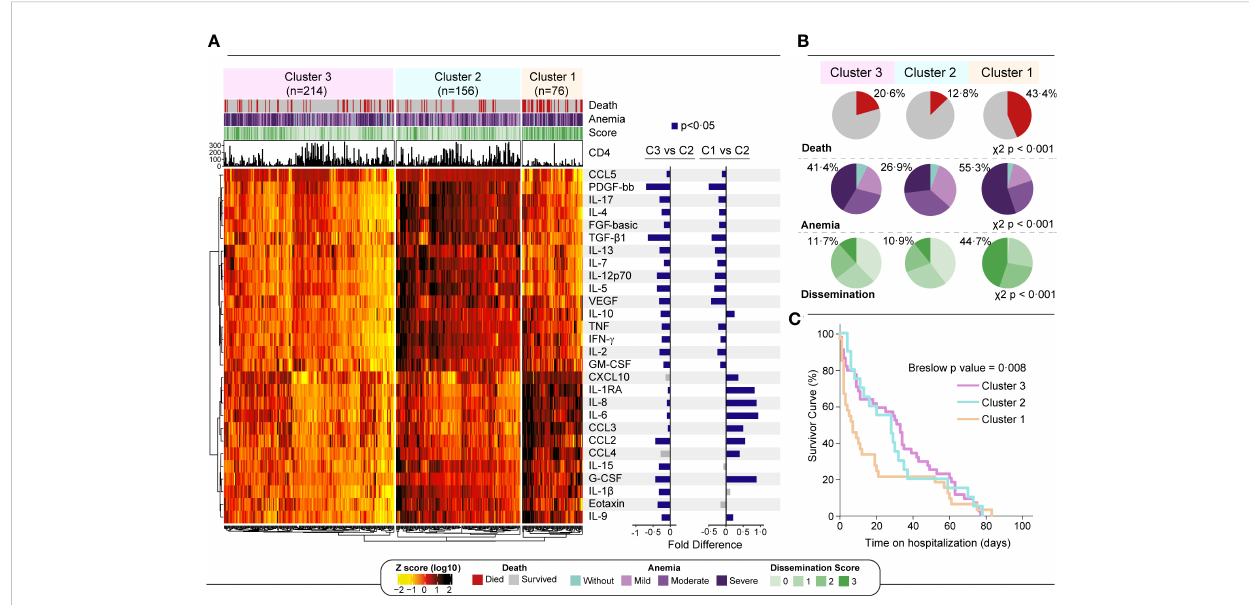
FIGURE 4 A more pronounced in fl ammatory pro fi le is associated with severe anemia and death. (A) Left panel: An unsupervised two-way hierarchical cluster (Ward ’ s method) was performed with all 496 participants. Data were log10 transformed and ranked and colored in a heatmap from values detected for each in fl ammatory biomarker. Dendrograms represent Euclidean distance. Three main clusters were de fi ned. Right panel: A log10 fold change was performed comparing each cluster with reference cluster (C2, due to lowest frequency of dissemination and death). Signi fi cant differences (p < 0.05) are highlighted in blue bars. (B) For each cluster, shaded areas represent frequency of death (red), anemia severity grade (light blue to dark purple) and Mtb dissemination score (light green to dark green) and. Chi squared test was performed to each variable comparing clusters. (C) Survivor curves show the probability of survival over 12 weeks for each cluster. Mild anemia was de fi ned as Hb value >10 g/dL and <13 g/dL for men; and >10 and <12 g/dL for women, whereas moderate anemia was de fi ned as Hb>8 g/dL and <=10 g/dL for both sexes. Severe anemia was de fi ned as Hb<8g/dL for both